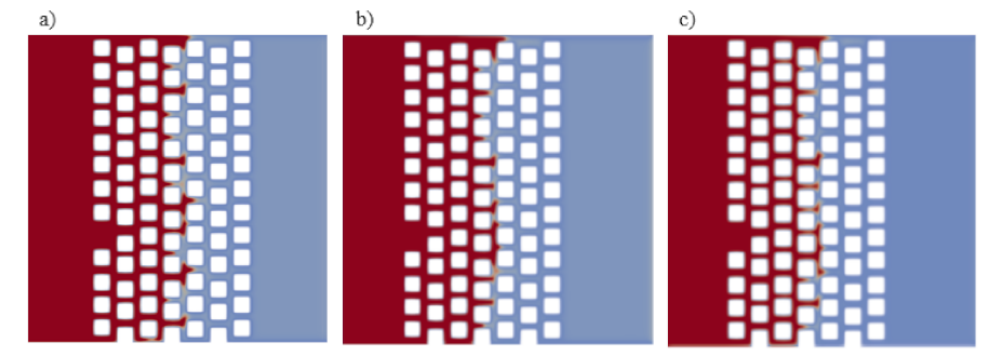
Figure 10. Gaseous phase penetration for square pores at t ∗ = 0.275, C a = 0.038, at: ( a ) D = 1; ( b ) D = 2; ( c ) D =